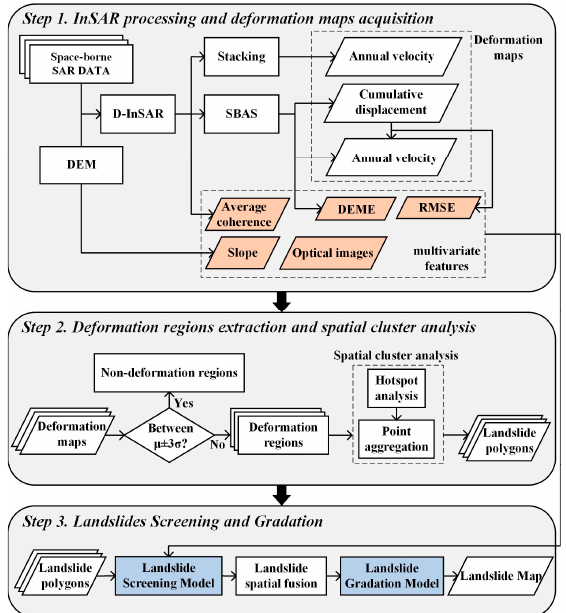
Figure 1. Flow chart of the proposed method.